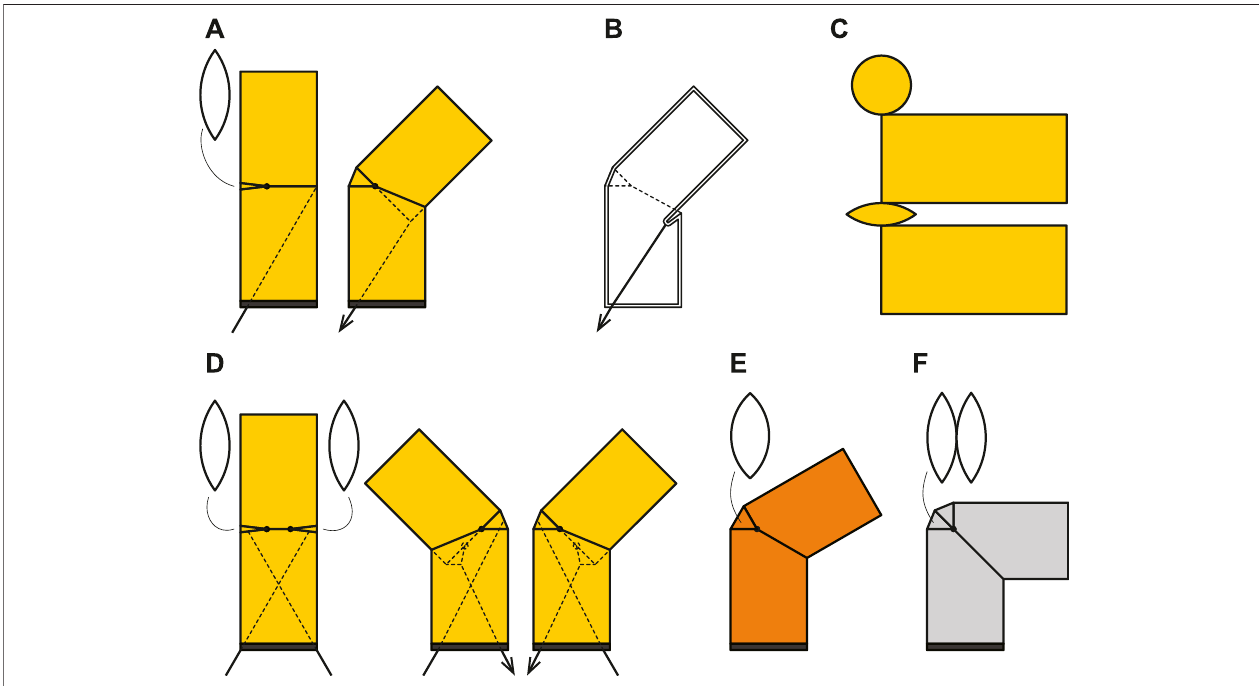
FIGURE1| Formsandstructuresofin fl atablejoints. (A) :anunilateraljointwithasingleleaf-shapedpatchesandatendonshowninsideview, (B) :Internalstructure and the pocket formed when the tendon is pulled, (C) : Pattern of unilateral joint for sewing. (D) : a bilateral joint with two leaf-shaped patches and two tendons, (E) : an unilateral joint with wide a patch, and (F) : an unilateral joint with a doubled leaf-shaped patch.